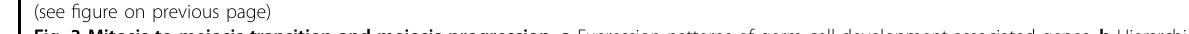
Fig. 3 Mitosis to meiosis transition and meiosis progression. a Expression patterns of germ cell development-associated genes. b Hierarchical clustering of differentially expressed mitotic and meiotic genes across female germ cell clusters (clusters 1 – 4). c Overlap of differentially expressed genes across germ cell clusters. d Differentially expressed genes and associated GO categories characteristic of meiosis initiation and progression, based on the four germ cell clusters. e Heatmap representing the key transcription factors across monkey germ cell clusters. f Hierarchical clustering of the transcription factors and human female germ cells. Each row represents a transcription factor, and each column represents a single human female germ